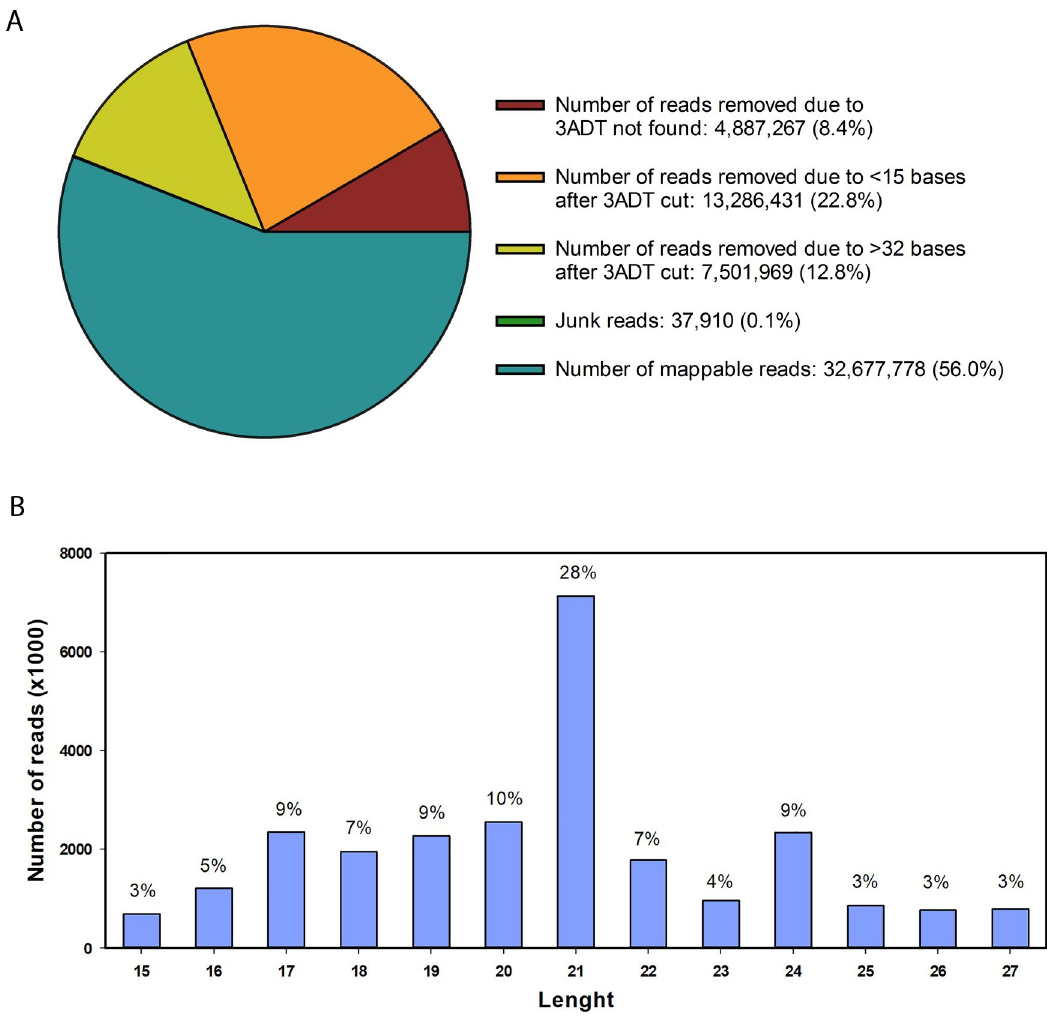
Fig 2. Data filtering and length distribution of mappable reads. Raw reads were filtered to remove sequences with no 3’ adapters (3ADT), junk reads and reads shorter than 15 and longer than 32 nucleotides; and were subsequently mapped to specific and selected genomes. (A) Pie plot of data filtering. (B) Length distribution of mappable reads.